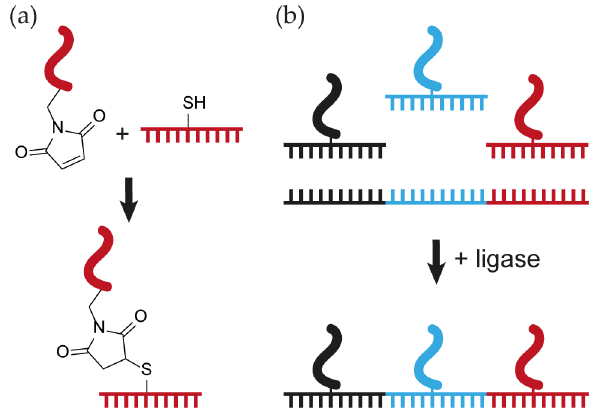
Figure 1. Scheme depicting our approach to prepare ligatable oligonucleotide conjugates. ( a ) Thiol– maleimide ligation using oligonucleotide with internal thiol modification conjugated to maleimide functionalized ligand and ( b ) ligase-catalyzed templated ligation of three different oligonucleotide conjugates, resulting in multifunctionalized DNA. S-shaped structure represents peptide sequence and comb-like structures belong to